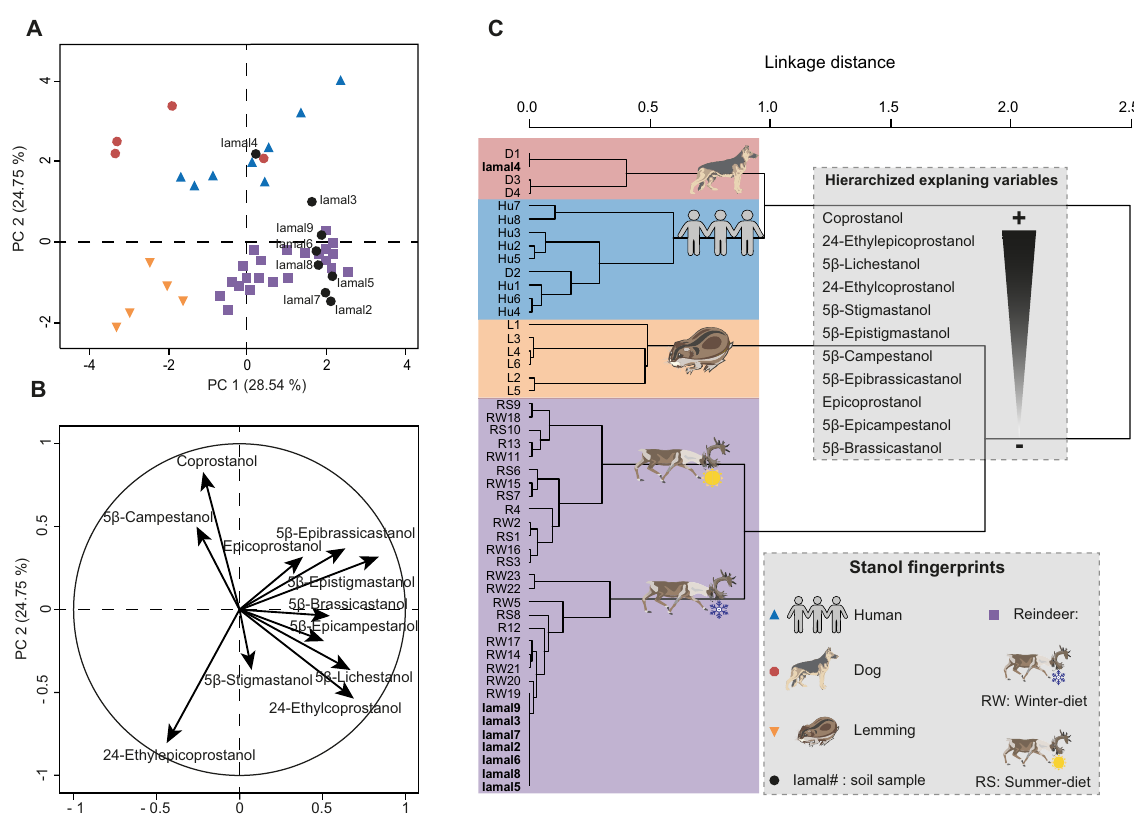
Fig 4. Identification of soil faecal fingerprints from the archaeological site of I ͡ Arte VI by multivariate analyses on eleven 5 β -stanol distributions. ( A ) PCA score plot of 5 β -stanol distributions from the reference library of faeces of dogs, lemmings, humans and reindeer, together with the 5 β -stanol distributions in the soil samples. PC1 and PC2 represent respectively principal components 1 and 2. The numbers in brackets show the variance explained by each PC. ( B ) PCA correlation circle. ( C ) HCPC dendrogram of dog (D), lemming (L), human (Hu), reindeer (R) and soil sample (Iamal) fingerprints. The main variables/compounds responsible for the distinction between the main clusters are hierarchized (from the more important + to the less import -) according to S6 Table. More details of the PCA/HCPC models can be found in S6 Table and sample information is in S2